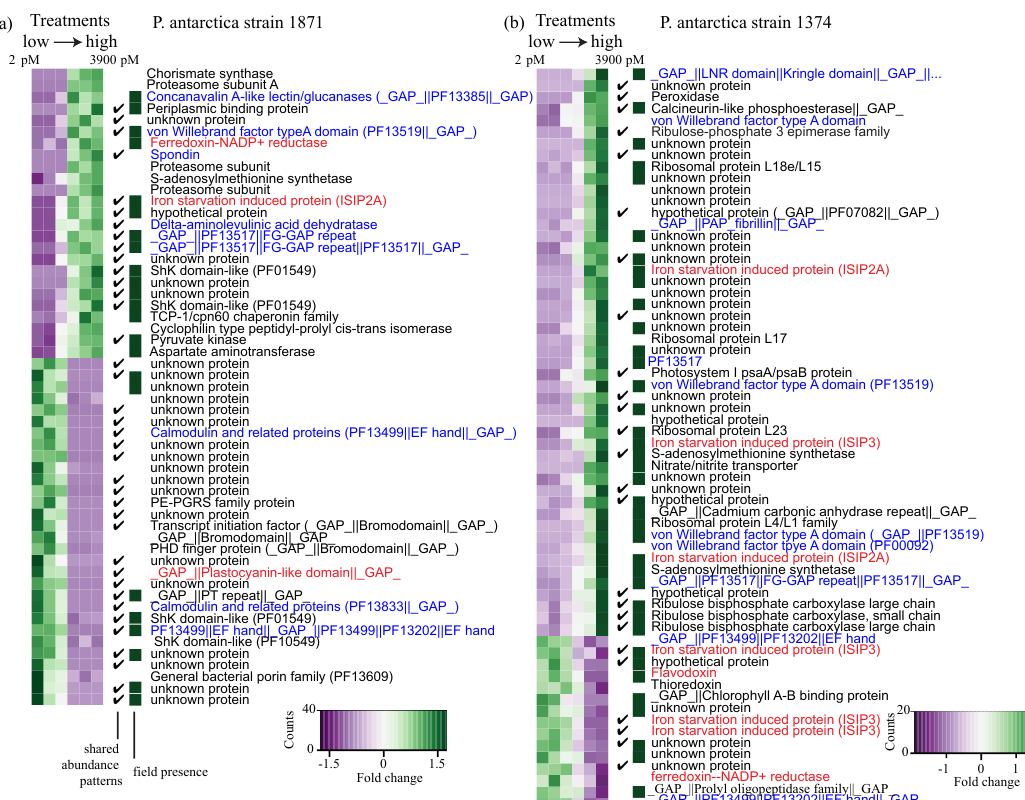
Figure 5. Heatmaps highlighting the relative protein abundance for the six treatments for P. antarctica strain 1871 (a) and strain 1374 (b) . The darker green color indicates a greater relative abundance compared to the purple treatments. The “shared abundance patterns” column features a checkmark when a shared response to changes in iron availability between the relative protein abundance and the transcript abundance was observed (for example, both transcripts and proteins have a higher abundance under high iron compared to low iron growth or both transcripts and proteins have a higher abundance under low iron compared to high iron growth). The “field presence” column indicates whether or not that protein was detected in the field metaproteome (annotated using Database 1). Protein annotations are based on KEGG, KOG, and PFam descriptions. Annotations in red are associated with iron metabolism and those in blue with cell adhesion and/or